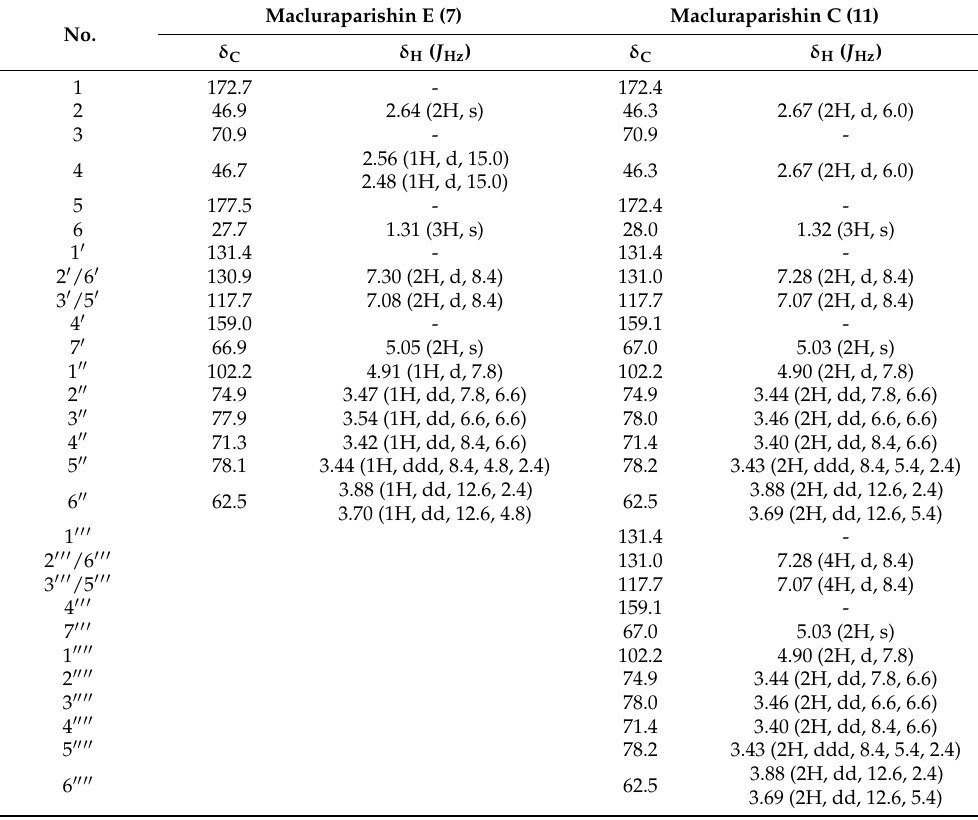
Table 2. The 13 C- and 1 H-NMR data for macluraparishins E and C. Macluraparishin E (7) Macluraparishin C No.